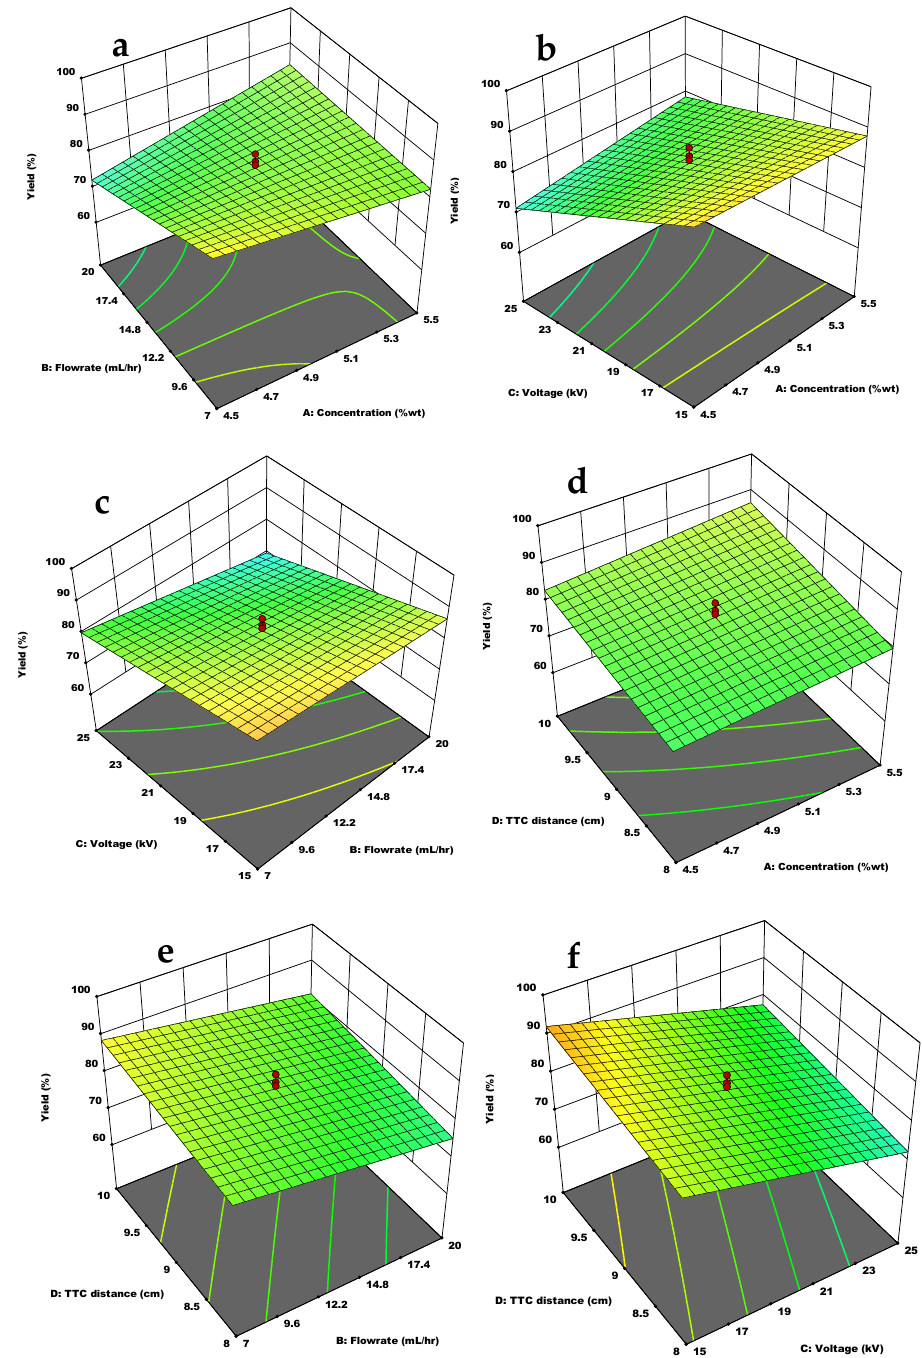
Figure 4. Response surface plot of the interaction effect of independent variables on yield: ( a ) Flow rate and concentration; ( b ) Voltage and concentration, ( c ) Voltage and flow rate; ( d ) TTC distance and voltage; ( e )TTC distance and concentration; ( f ) TTC distance and flow rate.